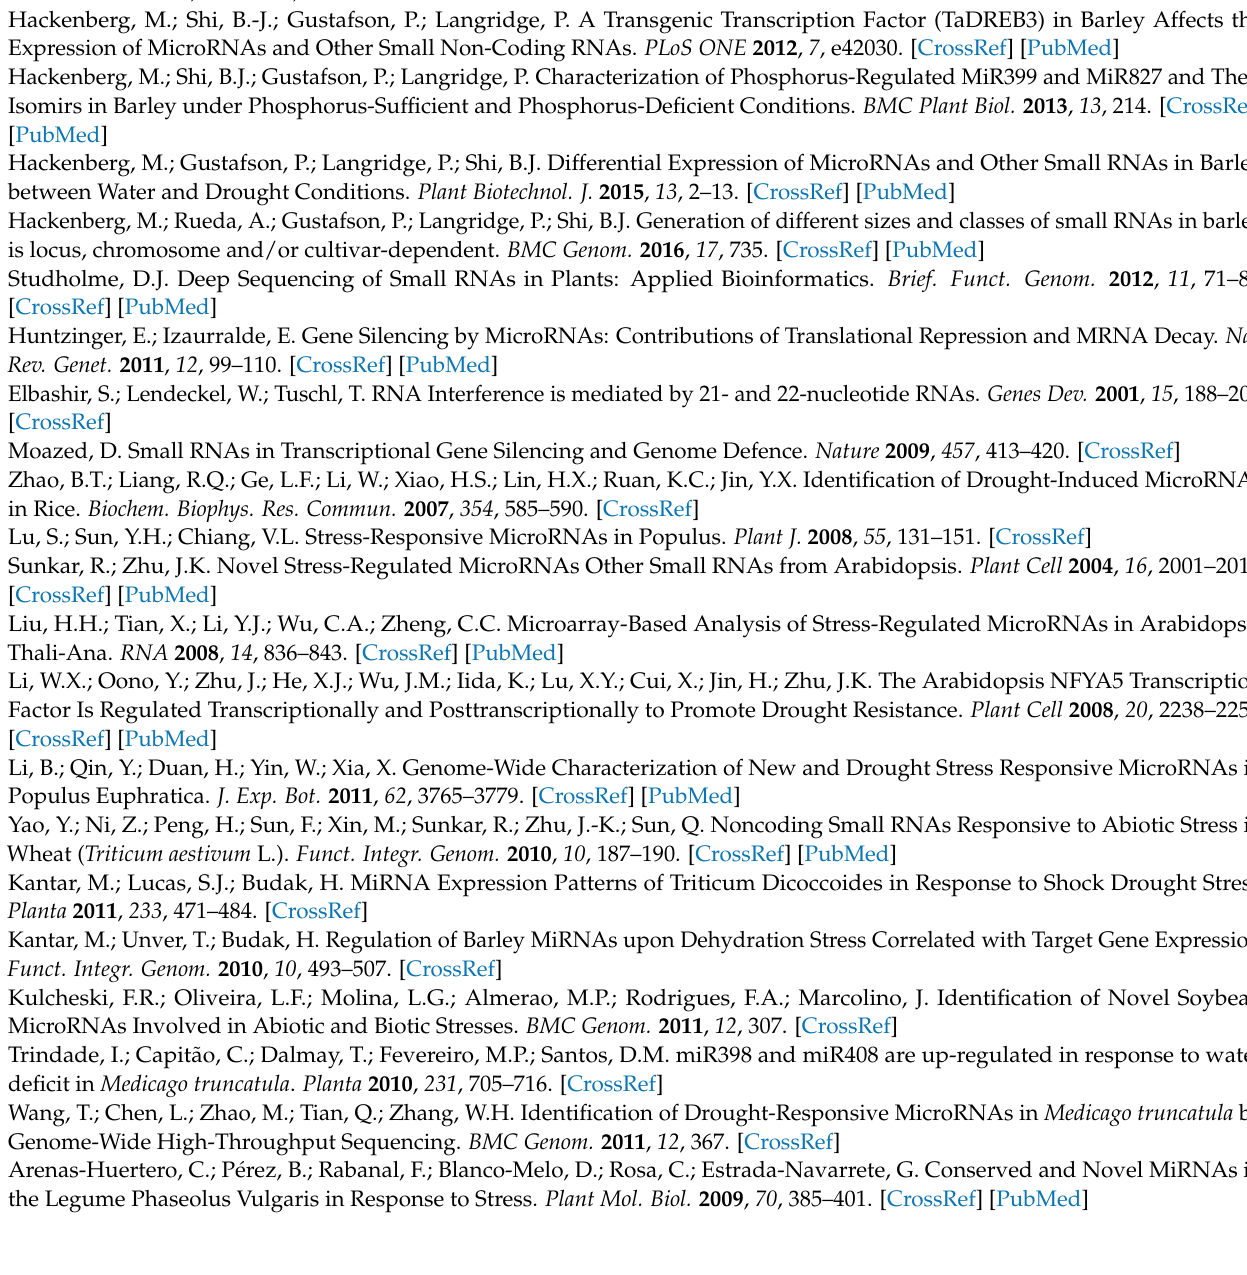
Table S8: Degradome based target-gene predicted interactions. Table S9: qRT-PCR assay information. Table S10: Enrichment of functional annotations in miRNA target genes. Table S11: Mature and hairpin sequences of predicted miRNAs. Table S12: Degradome miRNA-target interaction predictions using